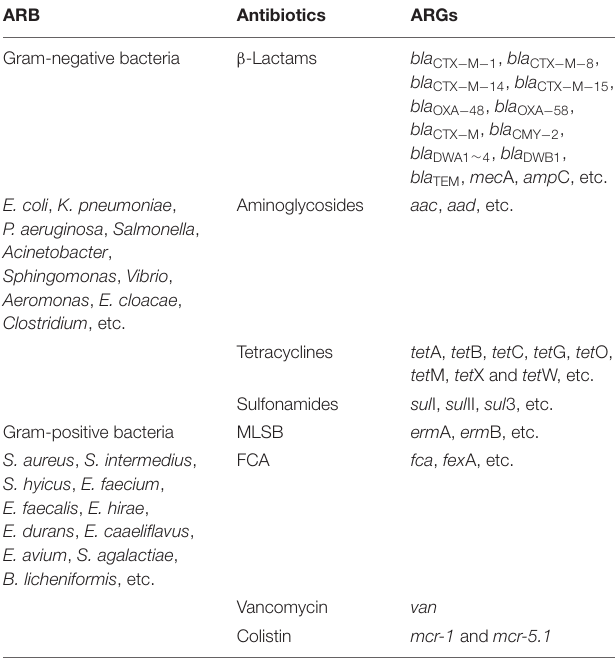
TABLE 1 | Typical antibiotics, antibiotic-resistant genes (ARGs), and antibiotic -resistant bacteria (ARB) in food animal